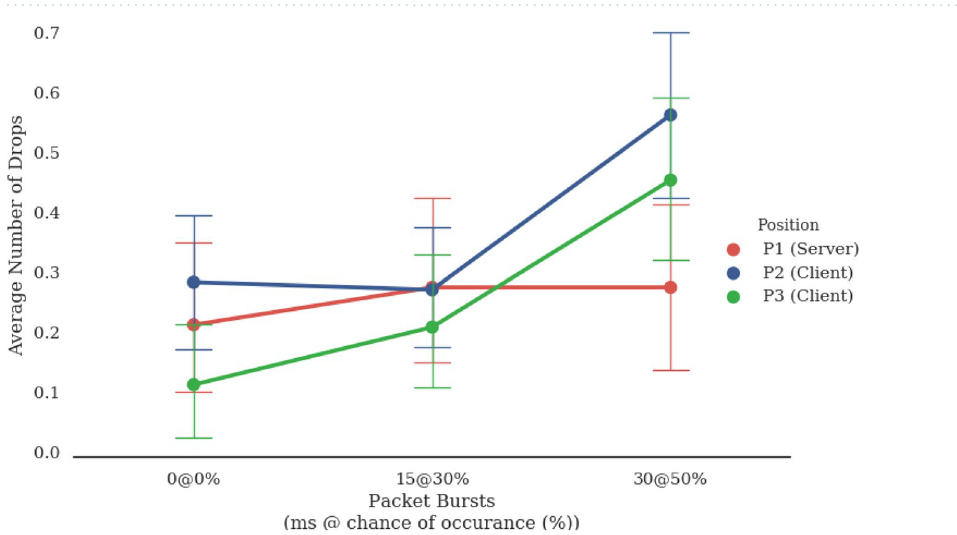
Figure 6. Frequency of drops (errors) by network role (position). Users whose computers functioned as the server performed better than users with client computers with the most packet